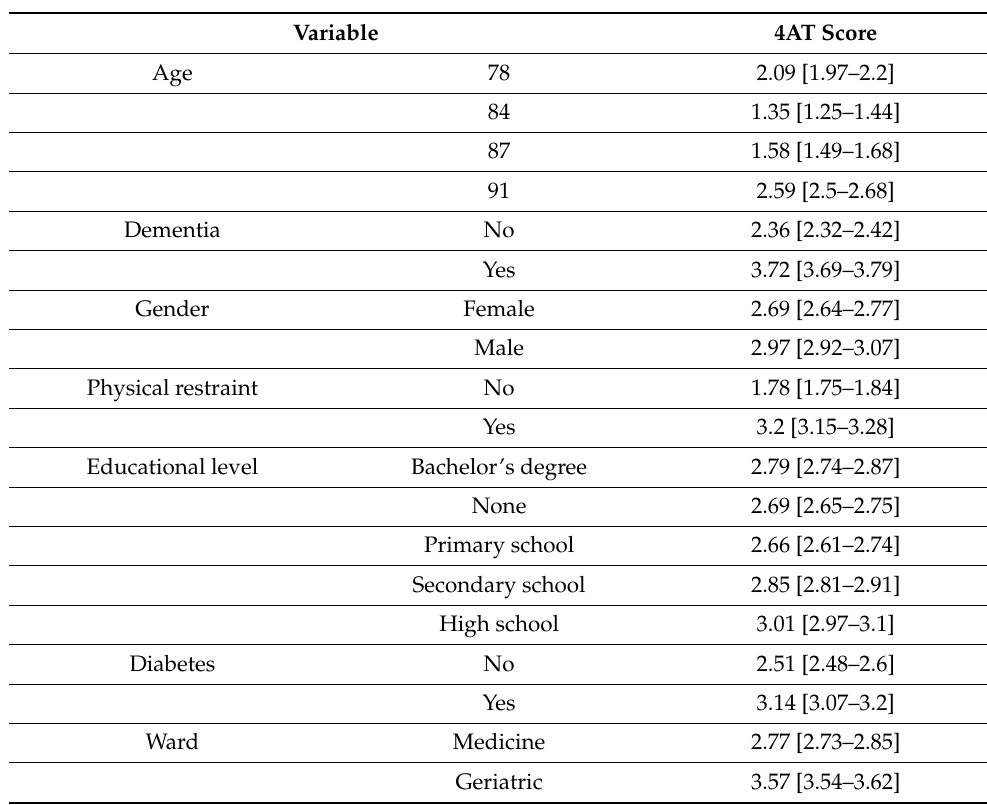
Table 2. Description of variables’ effect on the 4AT delirium score. The “4AT score” column reports the median (I and III quartiles) 4AT delirium score predicted by the model conditional on the variable’s